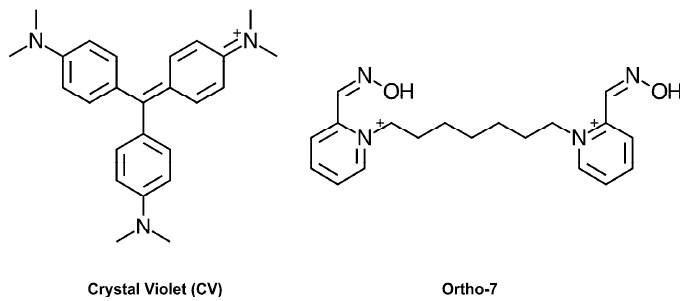
Figure 1. Chemical structure of crystal violet (CV) and Ortho-7.